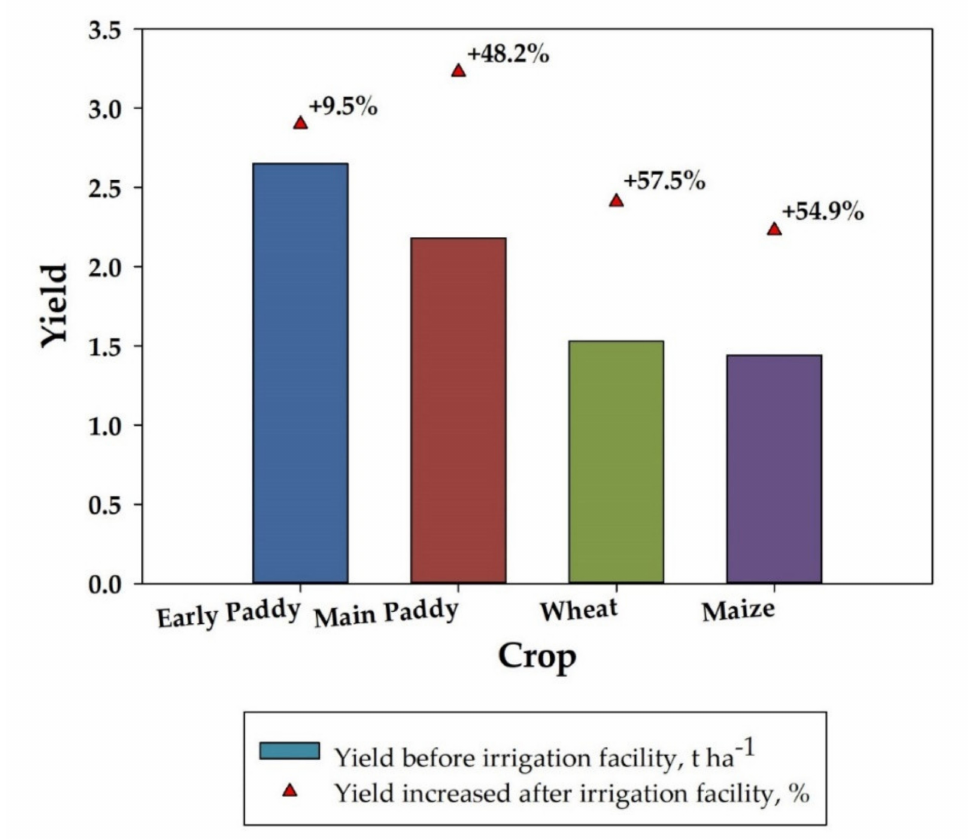
Figure 2. Yield of major cereals before and after irrigation facility through agency-managed irrigation system in